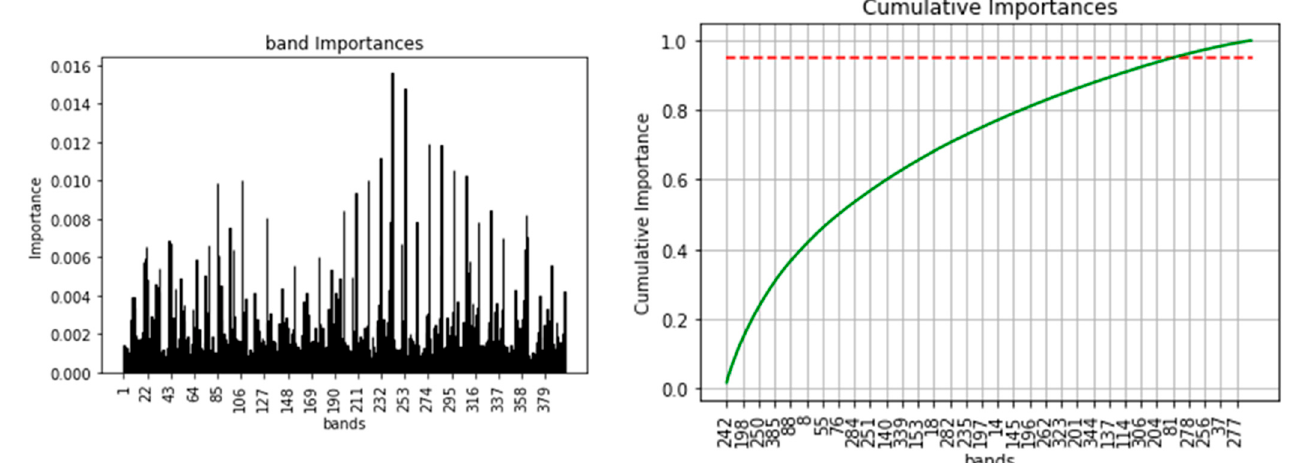
Figure 6. Band importance ( left ) and 95% cumulative importance ( right